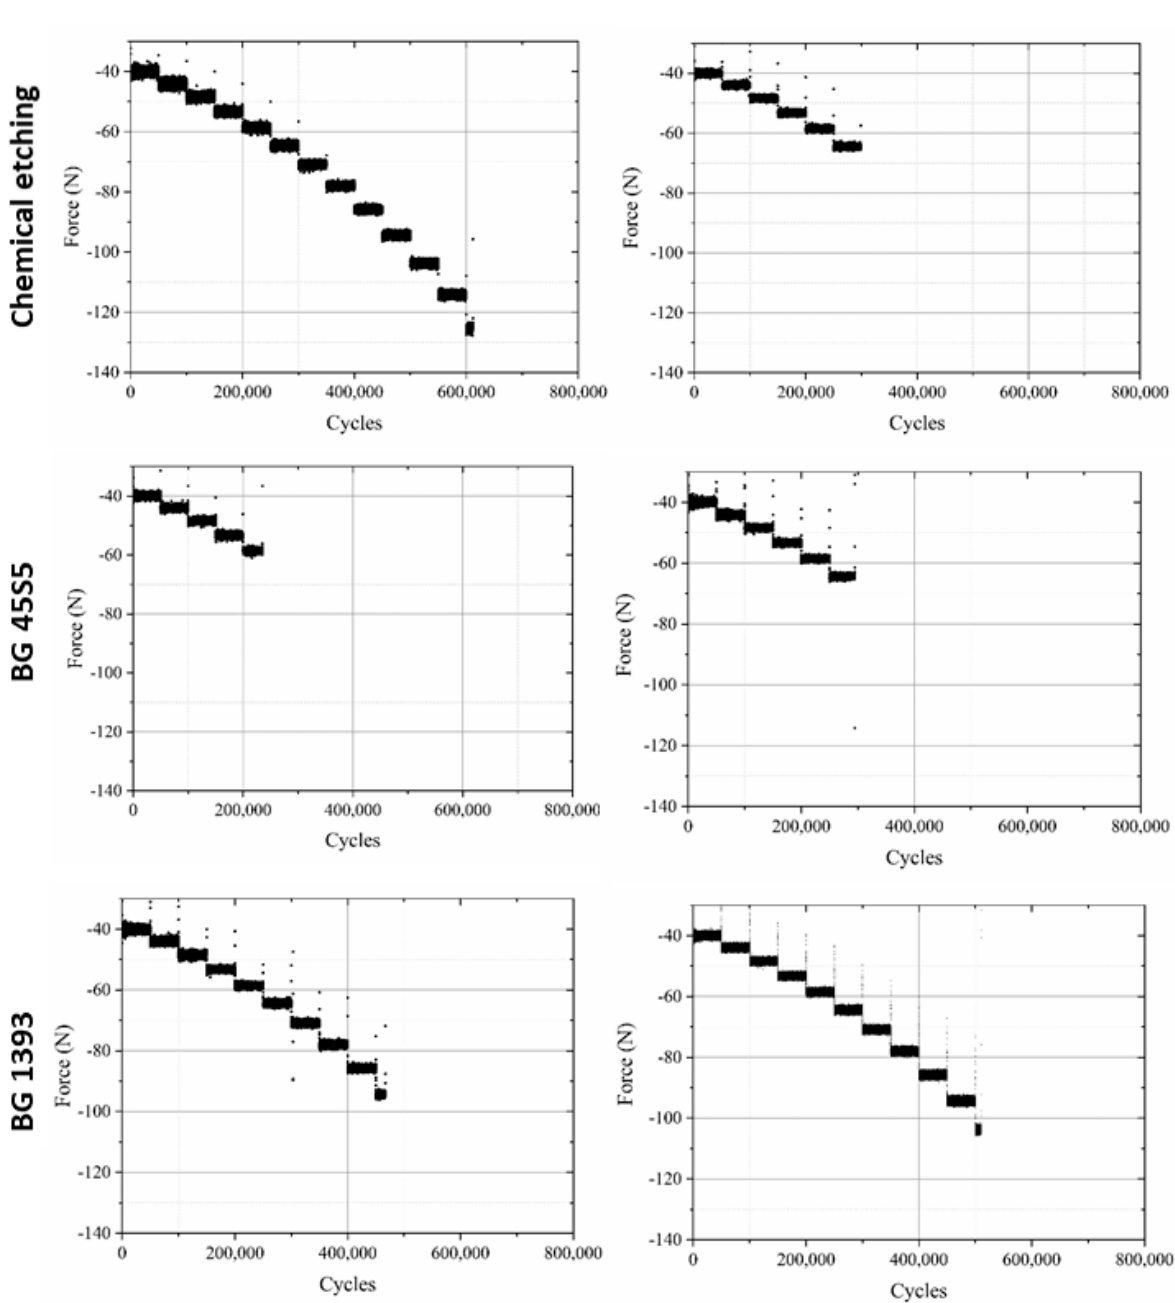
Figure 4. Fatigue behavior of PM and SH (30 vol.%) superficially modified implants (chemical etching, coated with BG 1393 or BG 45S5).